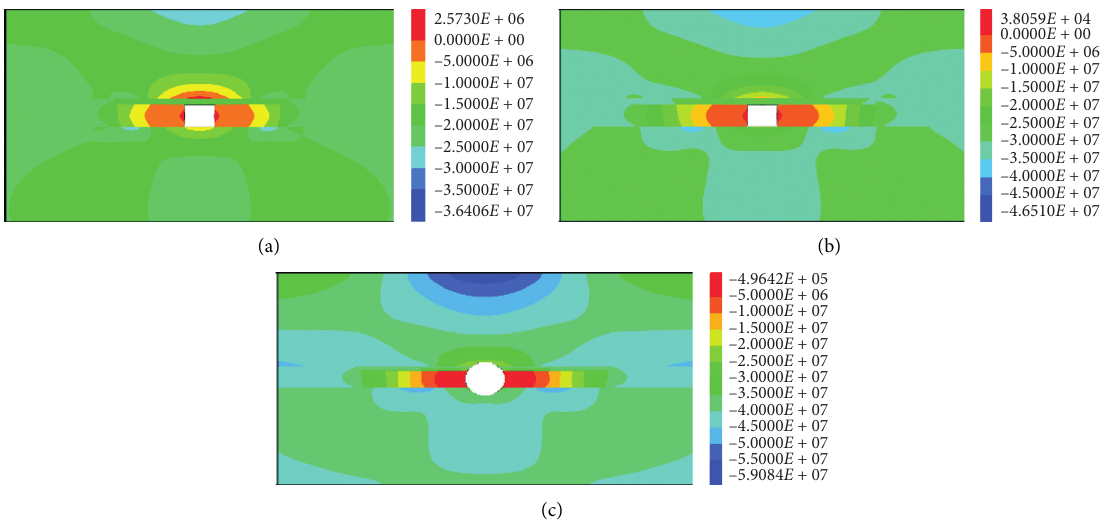
Figure 7: Horizontal stress of roof of different horizontal stresses: (a) 20MPa, (b) 30MPa, and (c)